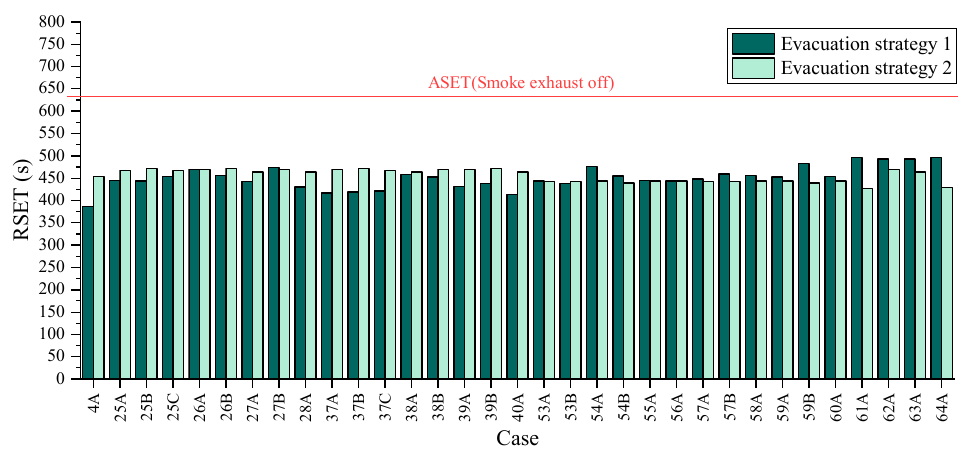
Figure 24. Comparison of the required safe evacuation time for the two evacuation strategies.